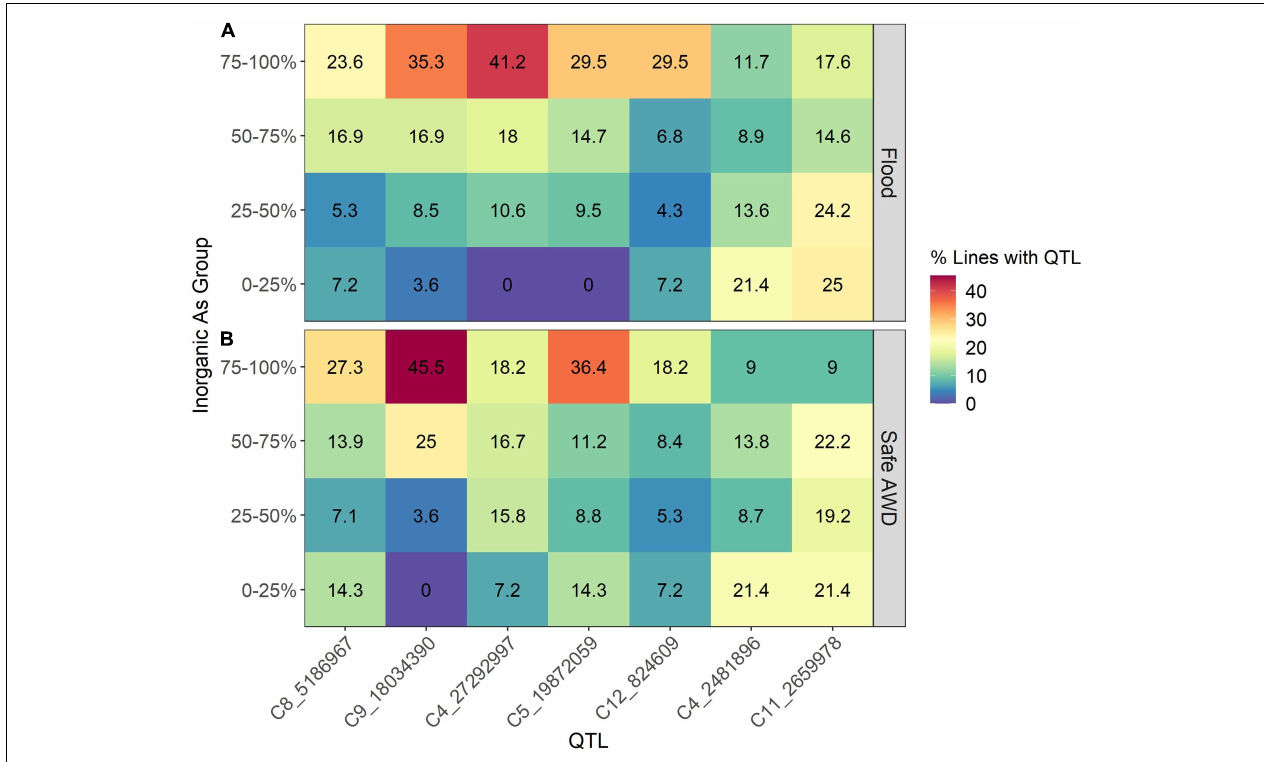
FIGURE 2 | Percent of lines containing each of the identified QTLs among groups based on the range of inorganic arsenic observed in each experiment (e.g., 0–25% represent those samples whose concentrations are < 25% of the maximum observed inorganic As for that experiment). (A) Flood 2013 and 2014; (B) Safe-AWD in